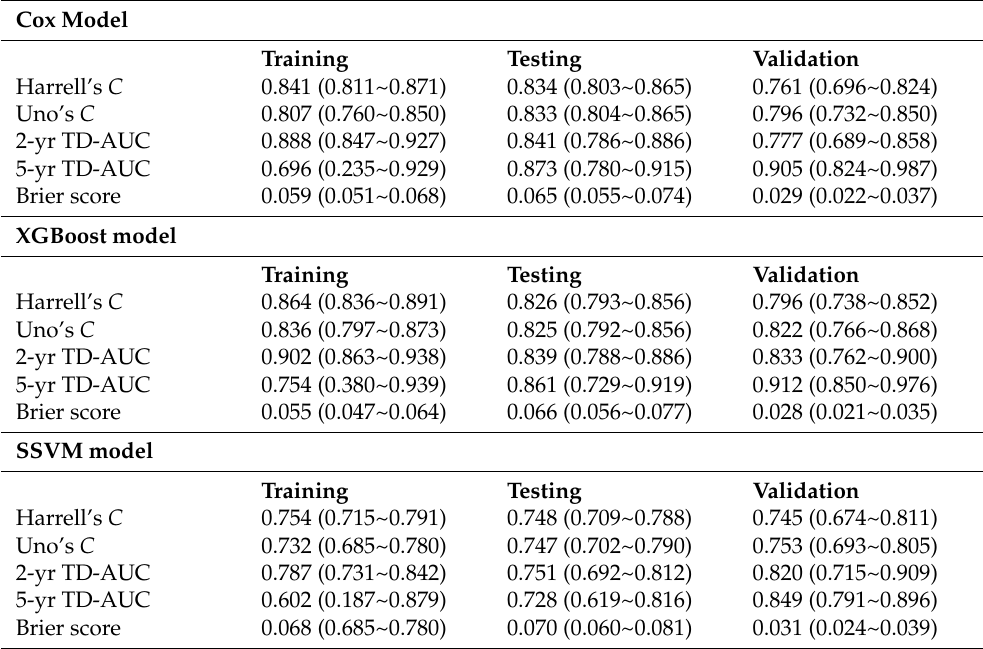
Table 2. Discrimination and calibration of the Cox, SSVM, and XGBoost models in the training, testing, and validation